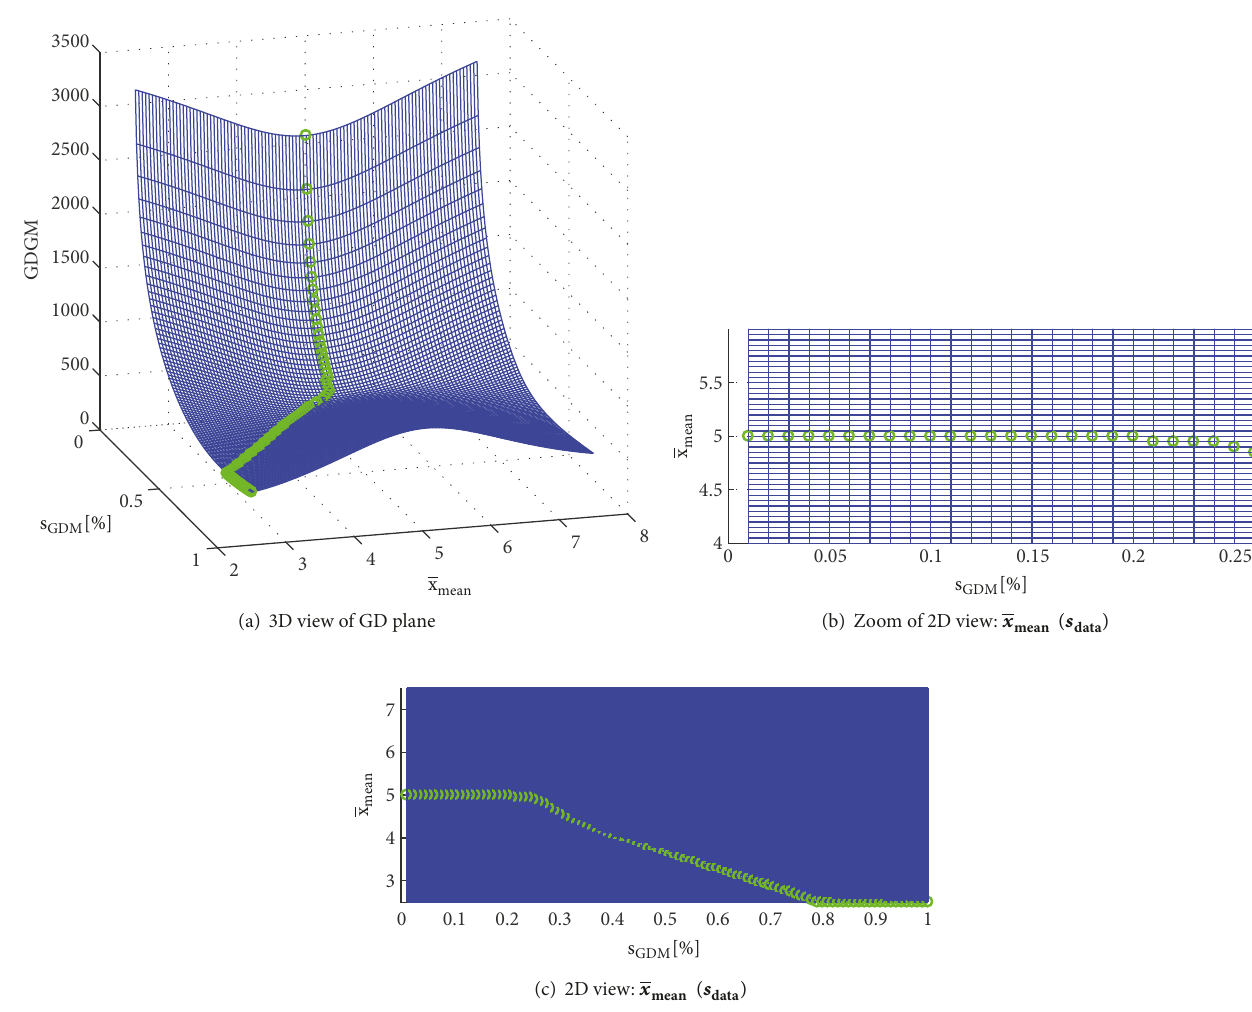
Figure 4: Pictorial description of the procedure to find the sigma of the additive Gaussian noise in the data. The plots correspond to the case of data sampled from a log normal distribution and an additive normal noise of 20% of the log-normal mean. On the left a 3D view of the scan in the sigma used to calculate the GDGM and indicated 𝑠 are reported. As can be seen, the inflection point in the 𝑥